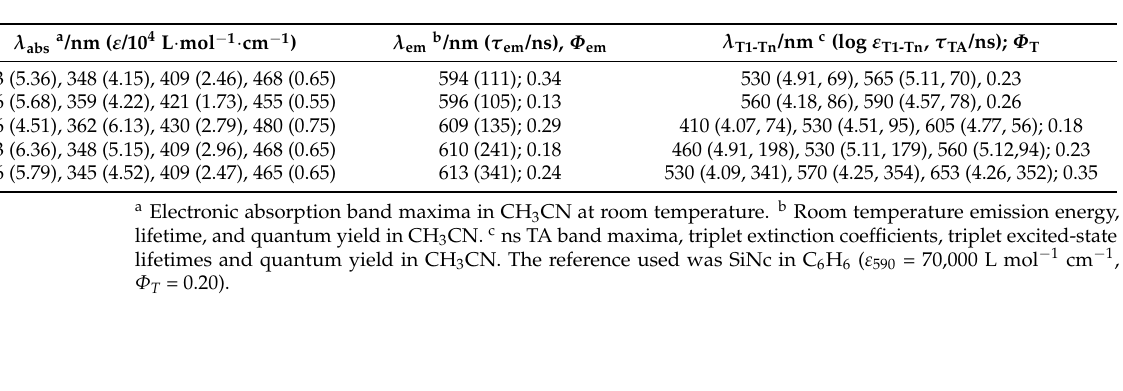
Figure 1. UV-vis absorption spectra of Ir-1 – Ir-5 in CH 3 CN (1 × 10 − 5 moL/L). Table 1. Photophysical data of complexes Ir-1 – Ir-5